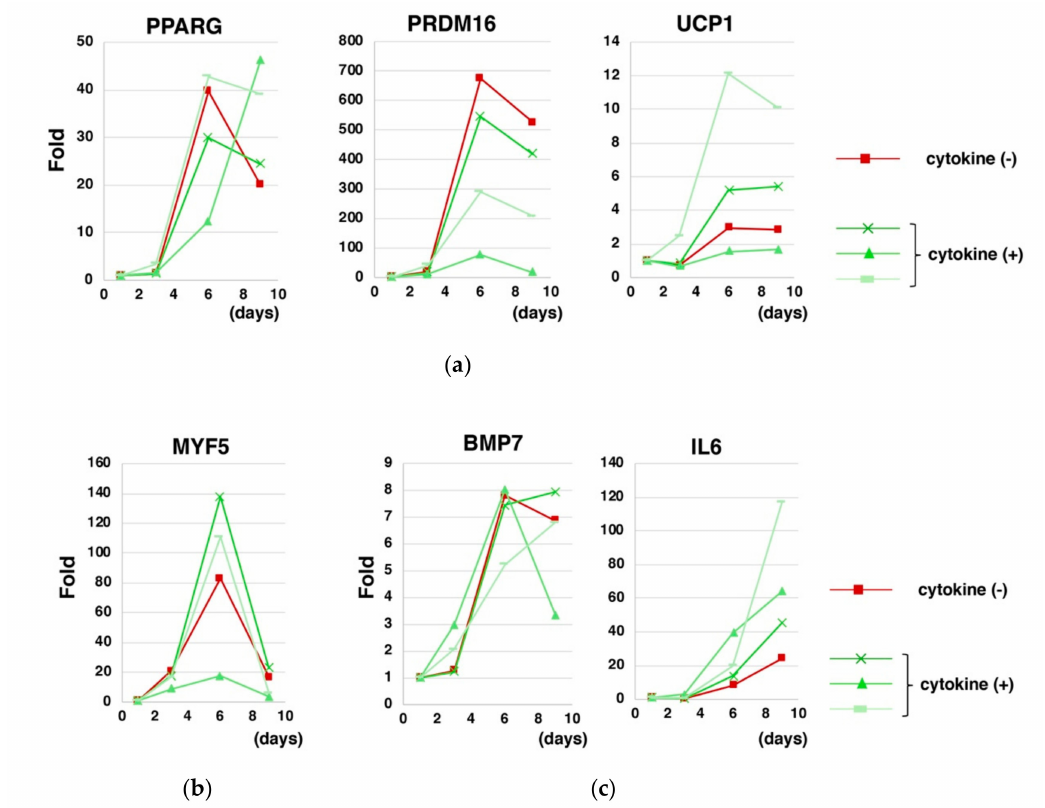
Figure 7. Supplementation of the cytokine cocktail did not significantly a ff ect the di ff erentiation of hESCs into BA in the upgraded method. hESCs (KhESC-1) were subjected to the di ff erentiation into BA using Elplasia ® 3D discovery tool in the absence (red) or presence (green) of the cytokine cocktail and gene expressions were analyzed over time. The presence of the cytokine cocktail did not influence the gene expression kinetics regarding BA marker genes ( a ), BA progenitor myoblast marker gene (MYF5) ( b ), and BAT-related genes (BMP7 and IL-6) ( c